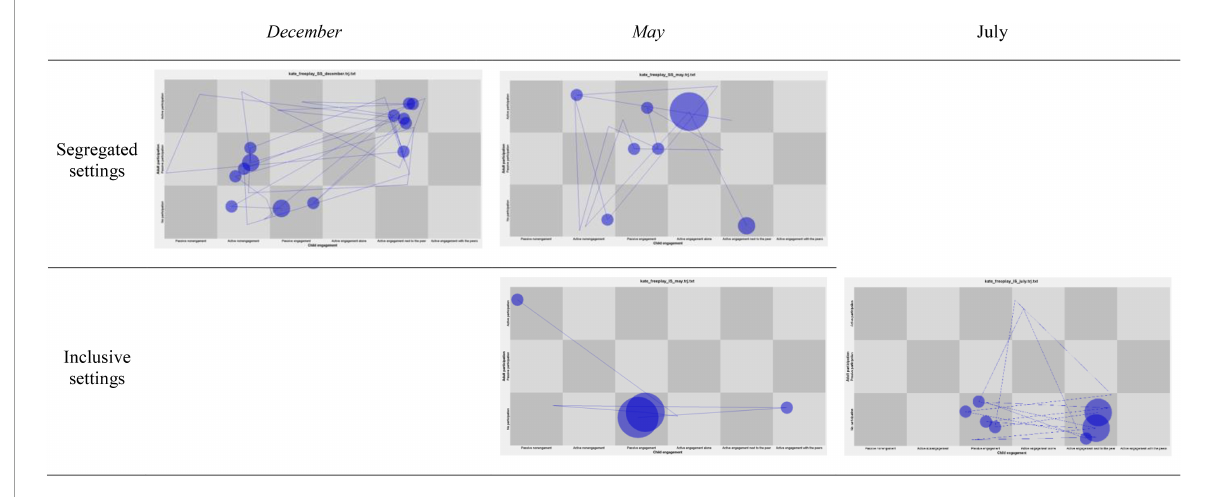
FIGURE1 State space grids during free play.